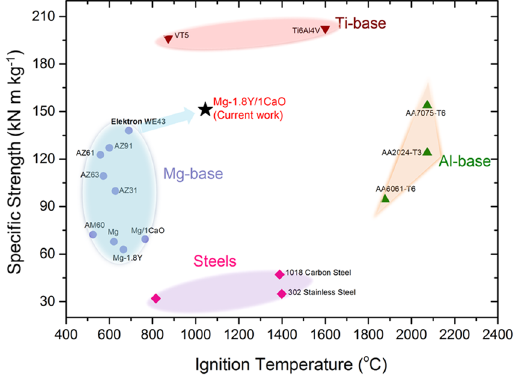
Figure 5. Density normalized tensile strength versus ignition temperature of Mg-1.8Y/1CaO in comparison with the commercial Mg-base alloys, Al-base alloys, Ti-base alloys and